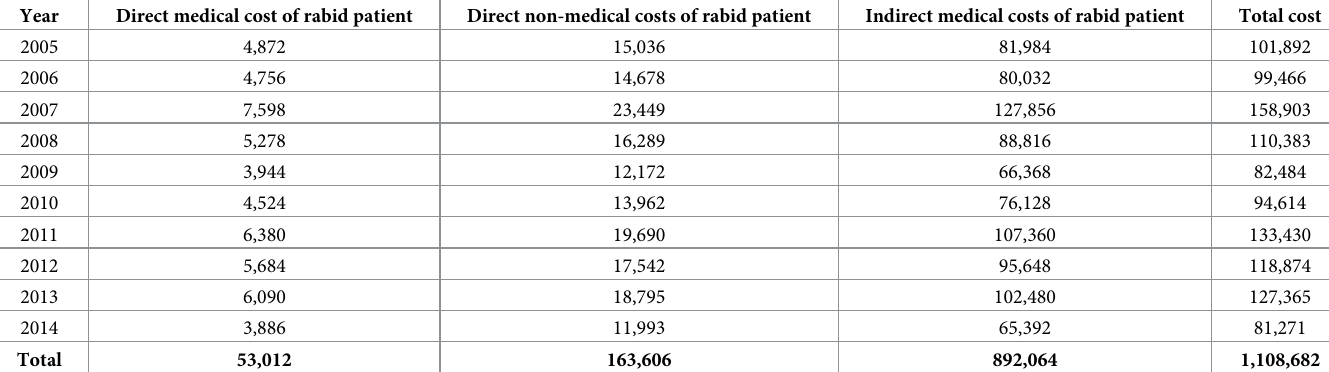
Table 8. Costs (in 2017 USD) associated with human rabies deaths in Viet Nam from 2005 to 2014.